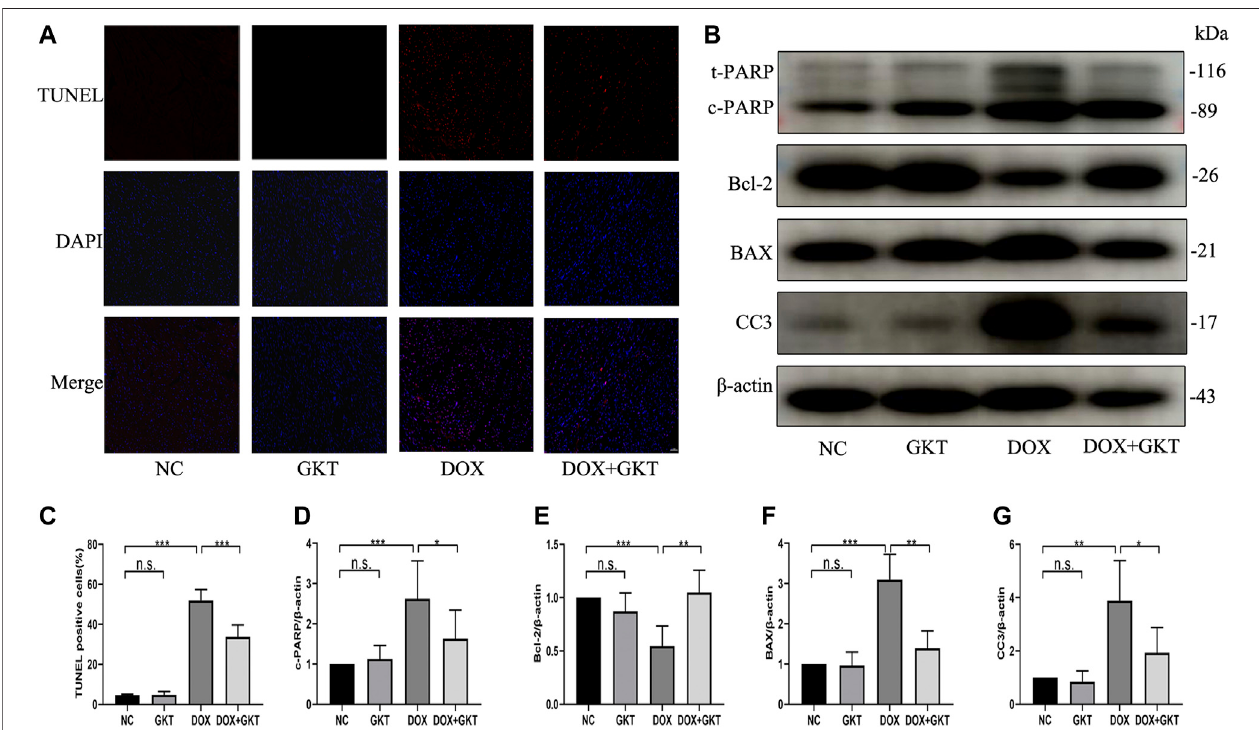
FIGURE5| GKT137831reducedDOX-induced cardiomyocyte apoptosis invivo . (A,C) Representativeimages ofTUNELstaininginmyocardialtissue (scalebar = 50 μ m)andrelatedquanti fi cationofTUNELstaining( n =5pergroup). (B) Representativewesternblotanalysisofc-PARP,Bcl-2,BAX,andCC3inmyocardialtissue,and quanti fi cations by densitometric analysis (D,E,F,G) , β -actin was used as a loading control ( n = 5 – 7 per group). * p < 0.05, ** p < 0.01, *** p < 0.001, n. s., not signi fi cant. DOX, doxorubicin; GKT, GKT137831; c-PARP, cleaved PARP; CC3, cleaved caspase 3.